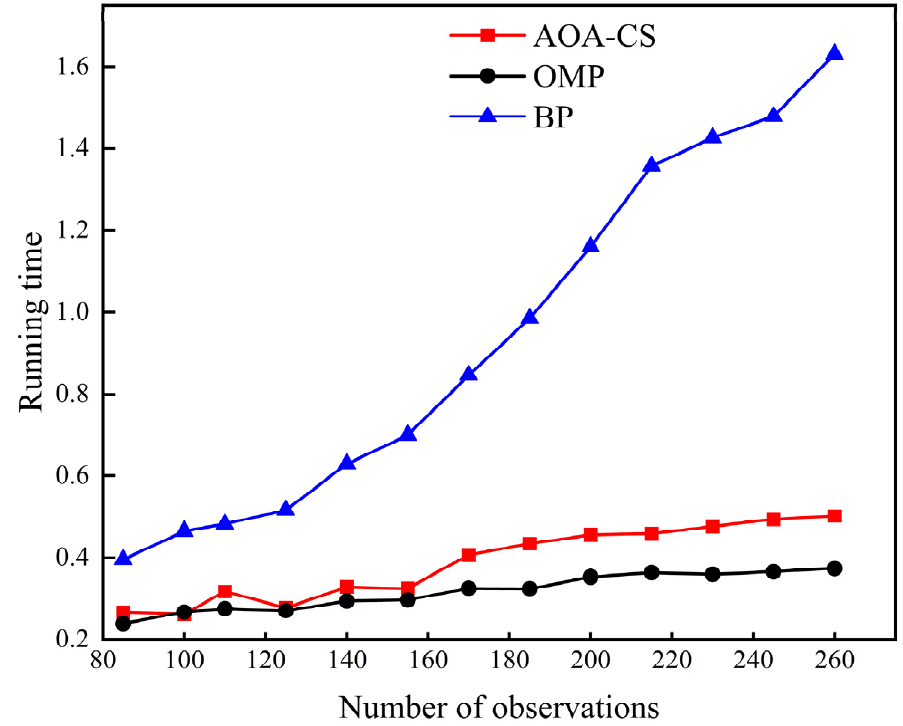
Figure 6. Average running time of each algorithm under different observation